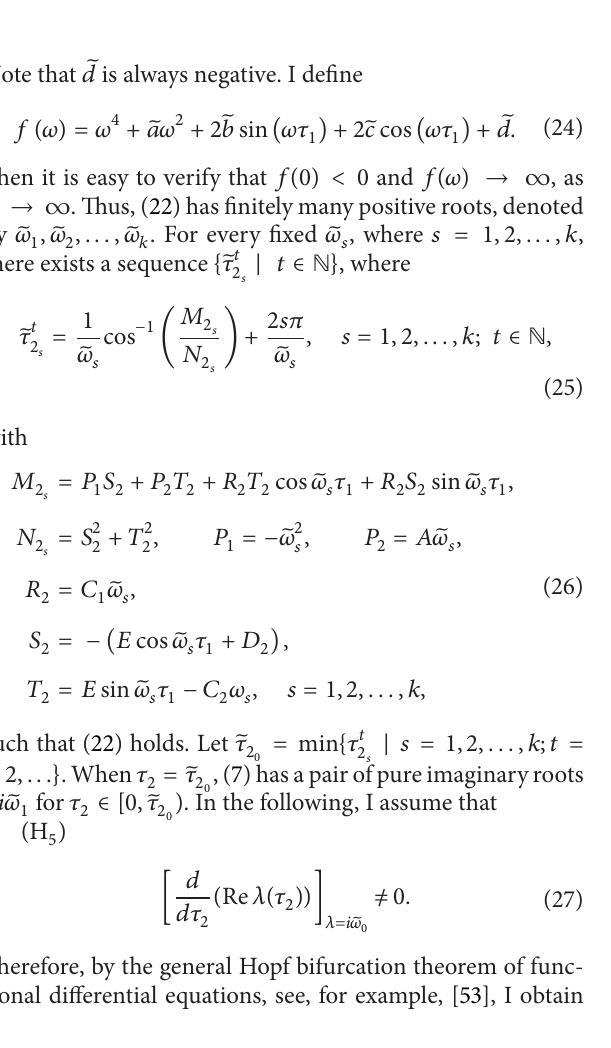
̃𝑑 Note that is always negative. I